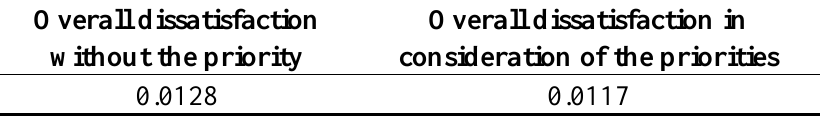
Table 7. Comparison between two types of overall dissatisfaction.